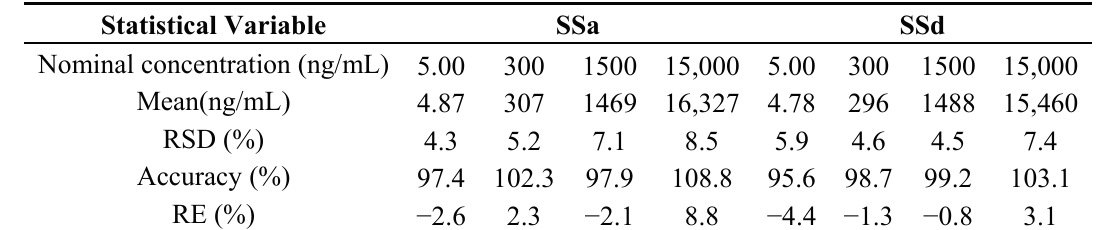
Table 11. Inter-batch accuracy and precision for the analysis of SSa and SSd in rat plasma ( n = 5). Statistical Variable SSa SSd Nominal